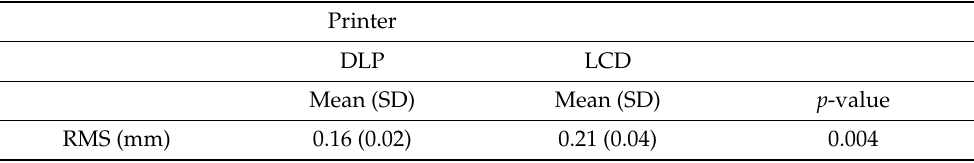
Table 1. Mean RMS value and standard deviation (SD) by printer type.